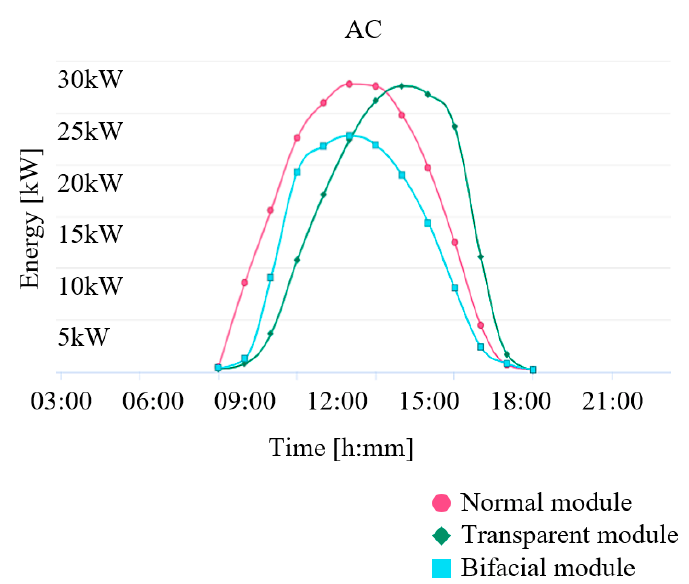
Figure 15. AC power-generation monitoring graph.